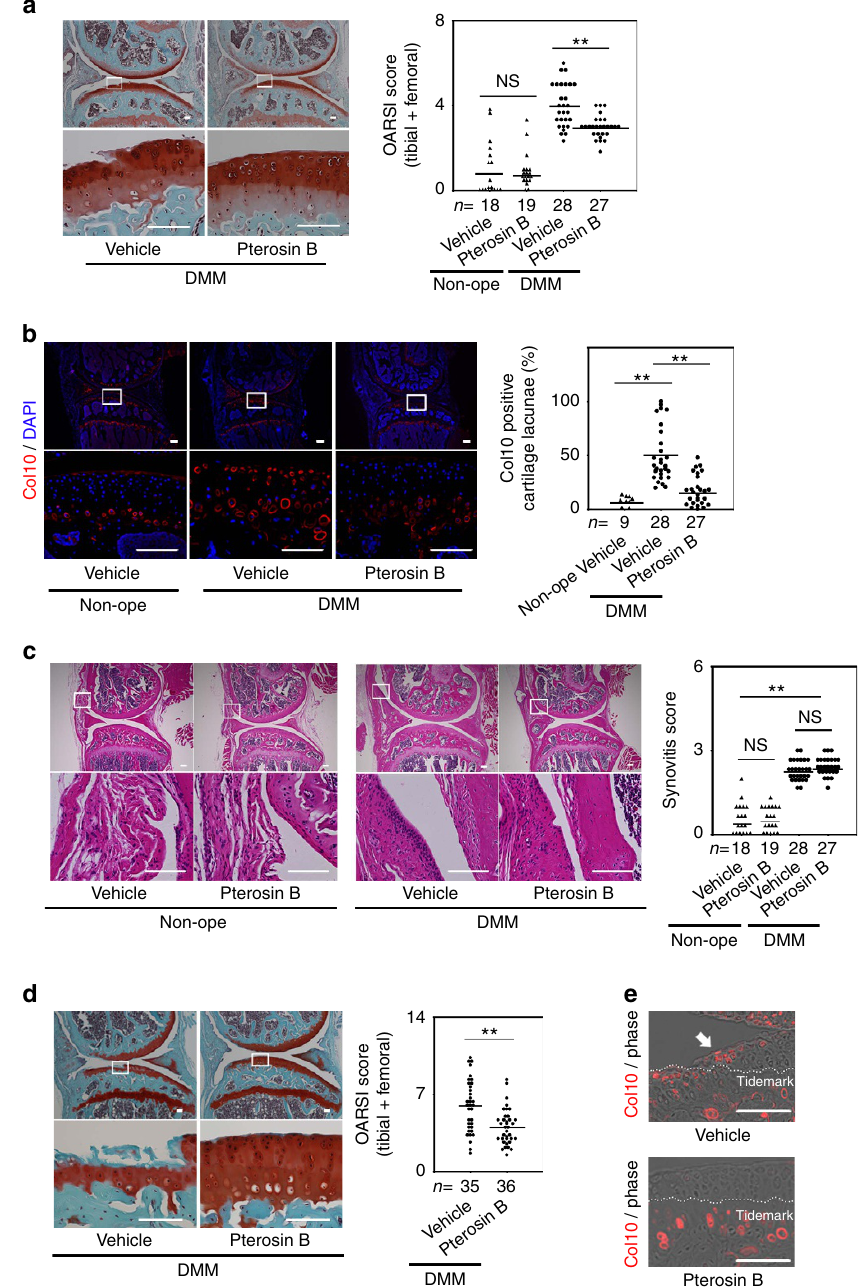
Figure 4 | Effects of pterosin B on osteoarthritis development in DMM-operated knees. ( a – c ) Eight-week-old mice with DMM were treated with pterosin B for 8 weeks. ( a ) Histology of articular cartilage of DMM-operated knees injected with pterosin B or vehicle. Safranin O-fast green-iron haematoxylin staining. Boxed regions in the top panels are shown in the bottom panels. OARSI scores of articular cartilage in DMM-operated knees injected with pterosin B or vehicle (black dots) are shown to the right. OARSI scoring was also done on non-operated knees injected with pterosin B or vehicle (black triangles). Two blinded scorers gave consistent results. Representative data are shown; Mann–Whitney test. ( b ) Immunohistochemistry for Col10 in knees. Boxed regions in the top panels are shown in the bottom panels. The percentage of lacunae surrounded by Col10-positive matrix per total number of lacunae is indicated. Tukey–Kramer post hoc test. ( c ) Histology of synovium; haematoxylin–eosin staining. Boxed regions in the top panels are shown in the bottom panels. Synovitis scores in DMM-operated knees injected with pterosin B or vehicle (black dots) and in non-operated knees injected with pterosin B or vehicle (black triangles); Mann–Whitney test. ( d , e ) Thirteen-week-old mice with DMM were treated with pterosin B for 12 weeks. ( d ) Histology of articular cartilage of DMM-operated knees injected with pterosin B or vehicle. Safranin O-fast green-iron haematoxylin staining. Boxed regions in the top panels are shown in the bottom panels. OARSI scores of articular cartilage in DMM-operated knees injected with pterosin B or vehicle are shown to the right. Two blinded scorers gave consistent results. Representative data are shown; Mann–Whitney test. ( e ) Immunohistochemistry for Col10 in articular cartilage in DMM-operated knees injected with pterosin B or vehicle. White dotted lines indicate tidemarks. White arrow represents Col10 expression above the tidemark. The images are representative of two independent experiments. Number of mice examined is indicated at the bottom of the graphs. * P o 0.05 and ** P o 0.01. NS, not significantly different. Scale bars, 100 m